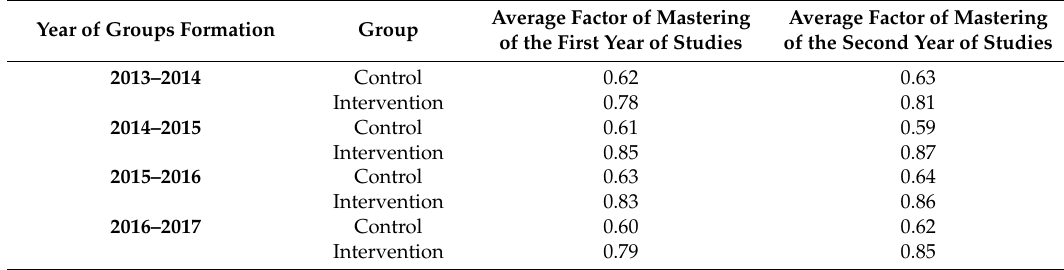
Table 2. Knowledge acquisition factor for control and intervention groups for three years of training.